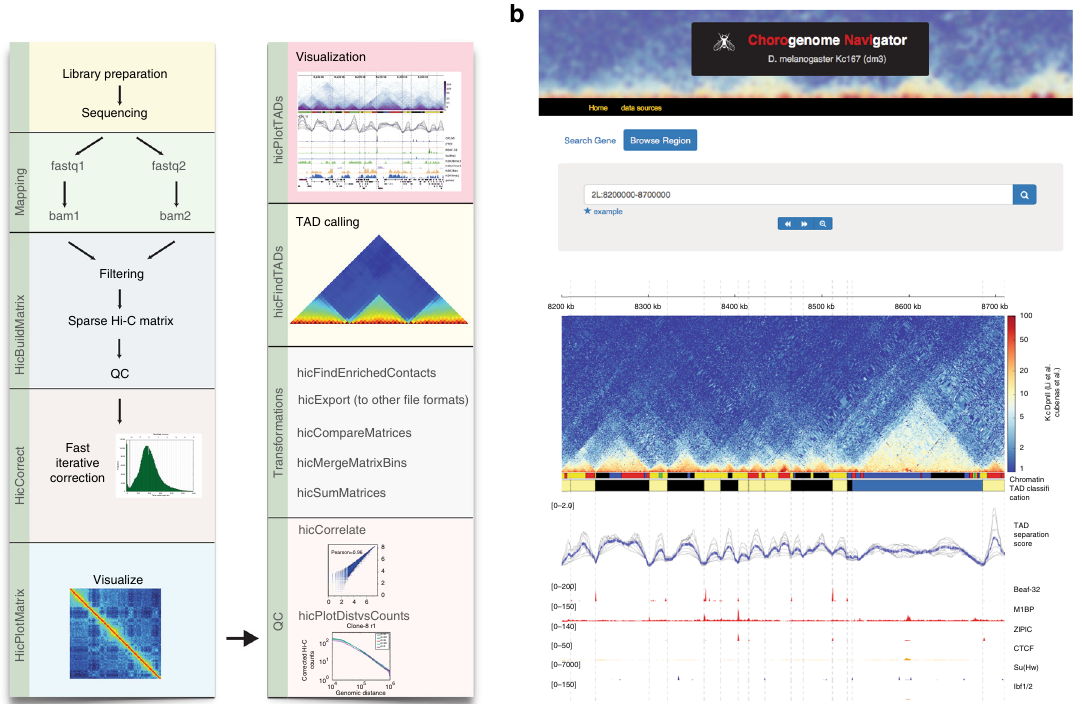
Fig. 6 HiCExplorer and Chorogenome navigator. a Pipeline of Hi-C processing and the commands used by HiCExplorer. HiCExplorer is easy to install ( conda install hicexplorer ), easy to use, tested (automatic tests and numerous data sets processed), well documented (https://hicexplorer.readthedocs.io/) and is ready to be used within the Galaxy framework 33 . b The Chorogenome navigator aims to be a repository for available Hi-C data. Currently, we host data from fl y, mouse and human. Customized tracks can be created using the HiCBrowser